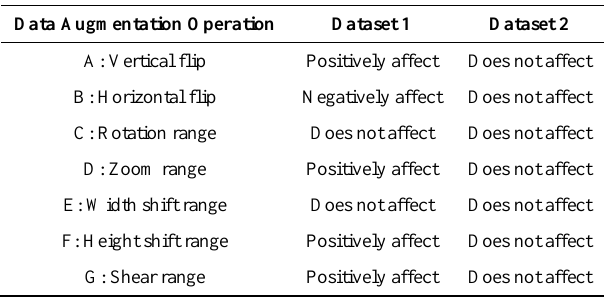
Figure 6. Cube analysis of the predicted classification accuracy on dataset 1. The optimal combination of data augmentation operations is when vertical flip (factor A) is true, horizontal flip (factor B) is false, zoom (factor D) is at its high level, shear (factor F) is at its high level, and height shift (factor G) at its high level. Table 6. Data Augmentation Operations Effects on